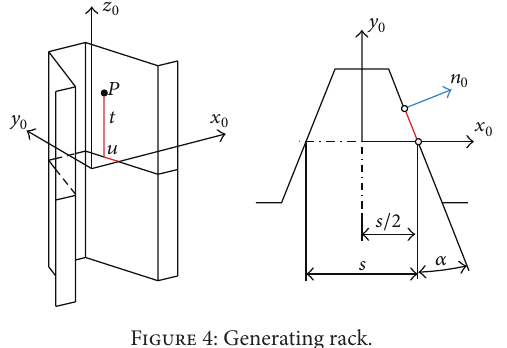
Figure 4: Generating rack.